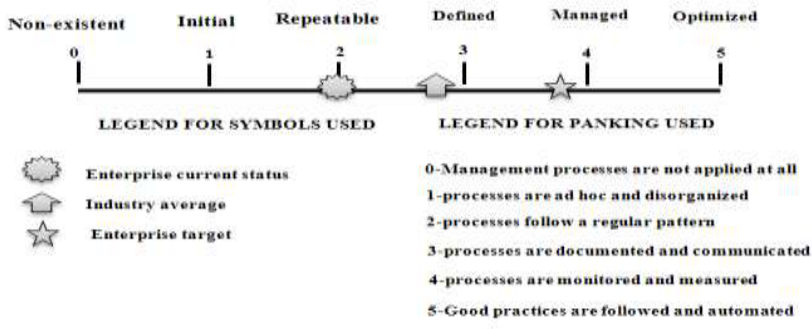
Figure 1. Graphic representations of COBIT 4.1 governance maturity model [19].